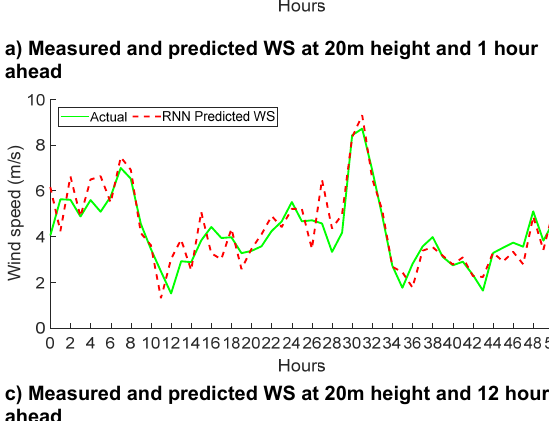
Figure 2. Performance at height